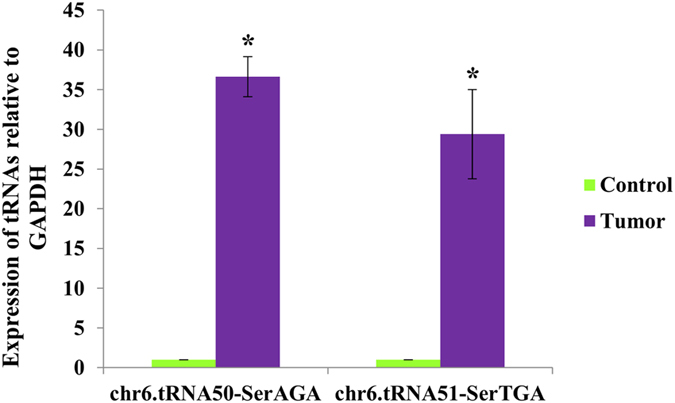
qRT-PCR validation of up-regulated tRNAs.qRT-PCR results of two representative tRNAs confirm their up-regulation in tumors (using GAPDH as the internal normalizer), as indicated by initial NGS experiments. *p < 0.05.